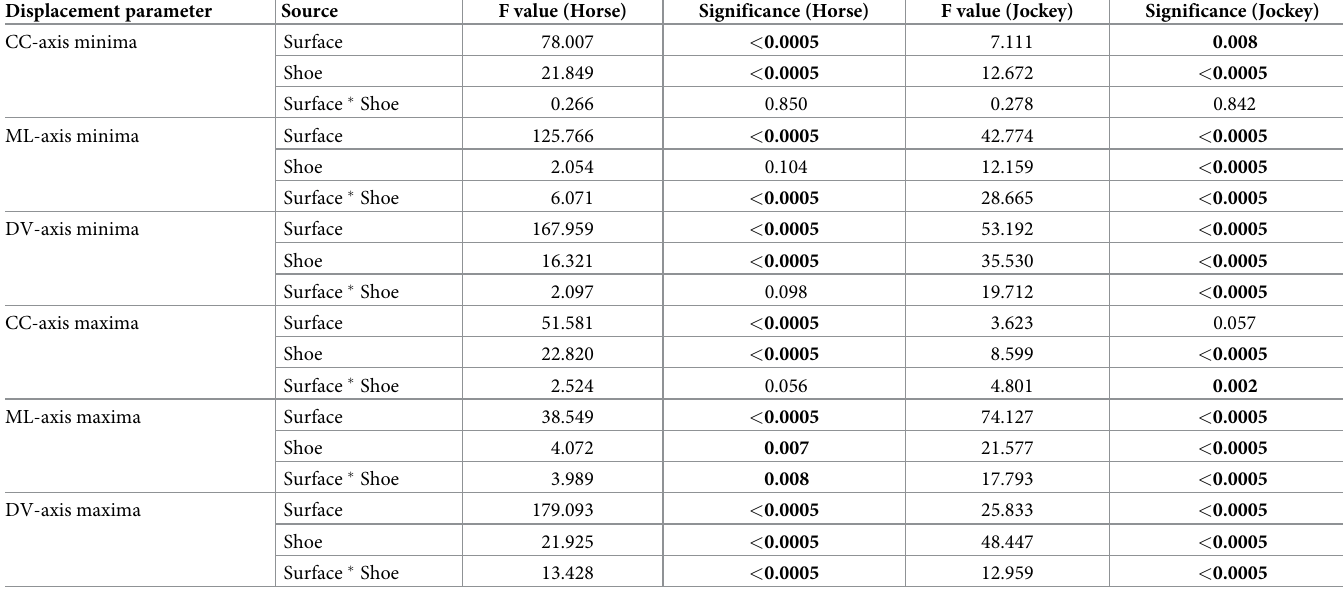
Table 6. Summary of output from linear mixed models: F and significance (p) values. Displacement